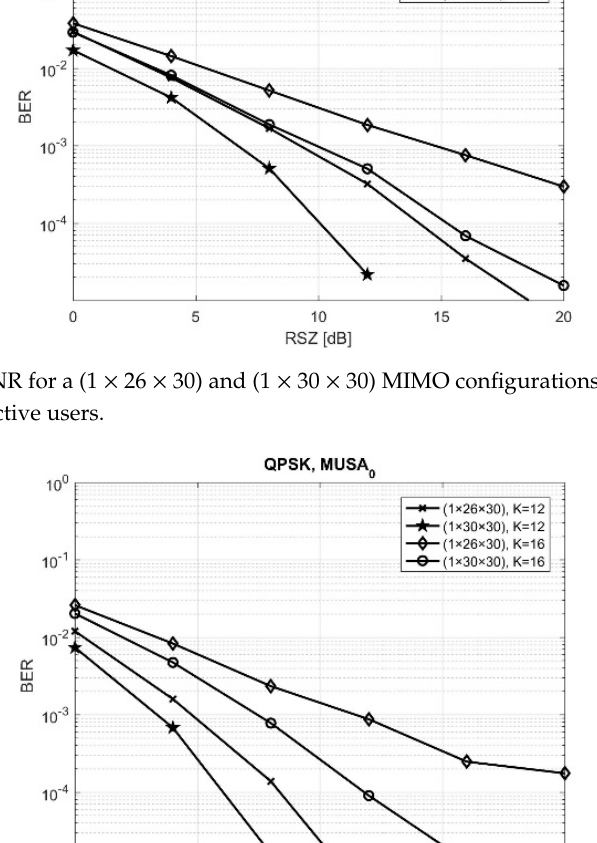
Table 3. BER vs. SNR for MUSA and MUSA 0 for SNR = 12 dB. (1 × 26 × 30)